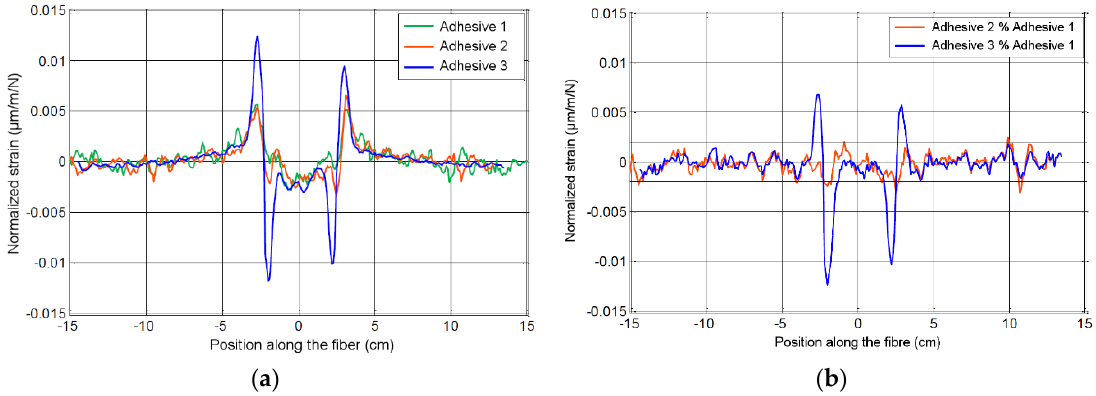
Figure 12. ( a ) Normalized strain profiles (mean signal averaged on all profiles obtained at the various load levels) for joints of all adhesive systems; ( b ) comparison of the normalized strain profiles for joints of Adhesives 2 and 3 with respect to the profile of Adhesive 1.